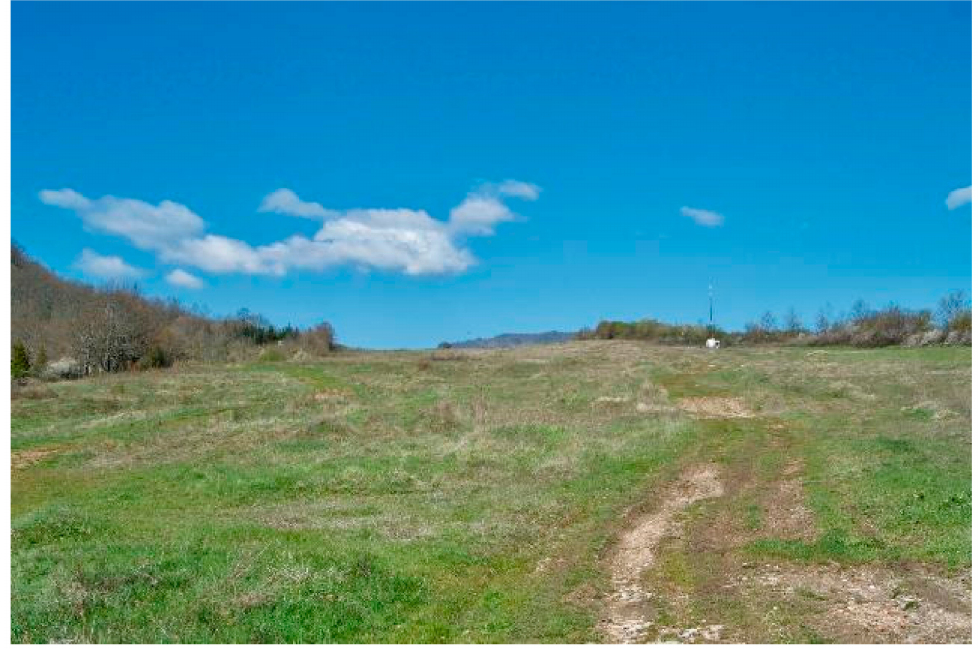
Figure 7. Tratturo image in the municipality of Pescolanciano (IS). Capecelatro’s Atlas Sheet 280, Bonamici’s reinstatement Table LXIII, Tablet IGM 153